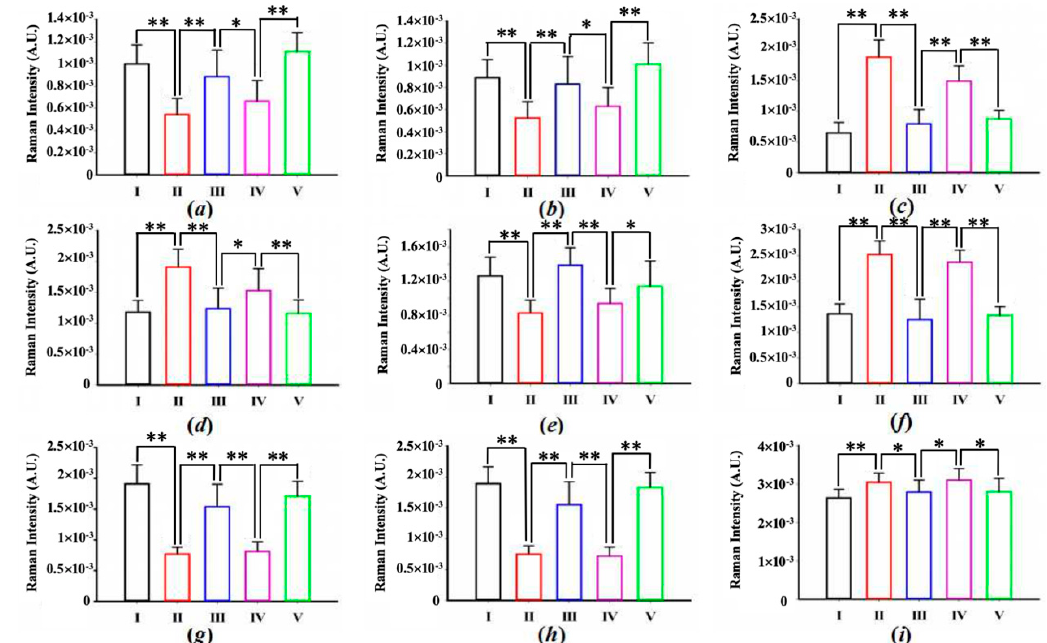
Figure 3. Intensity measures for each kind of composition. ( a ) 720 cm − 1 ; ( b ) 753 cm − 1 ; ( c ) 853 cm –1 ; ( d ) 936 cm –1 ; ( e ) 1002 cm –1 ; ( f ) 1248 cm − 1 ; ( g ) 1305 cm − 1 ; ( h ) 1327 cm − 1 ; ( i ) 1450 cm − 1 . Take the spectra ( d ) 936 cm